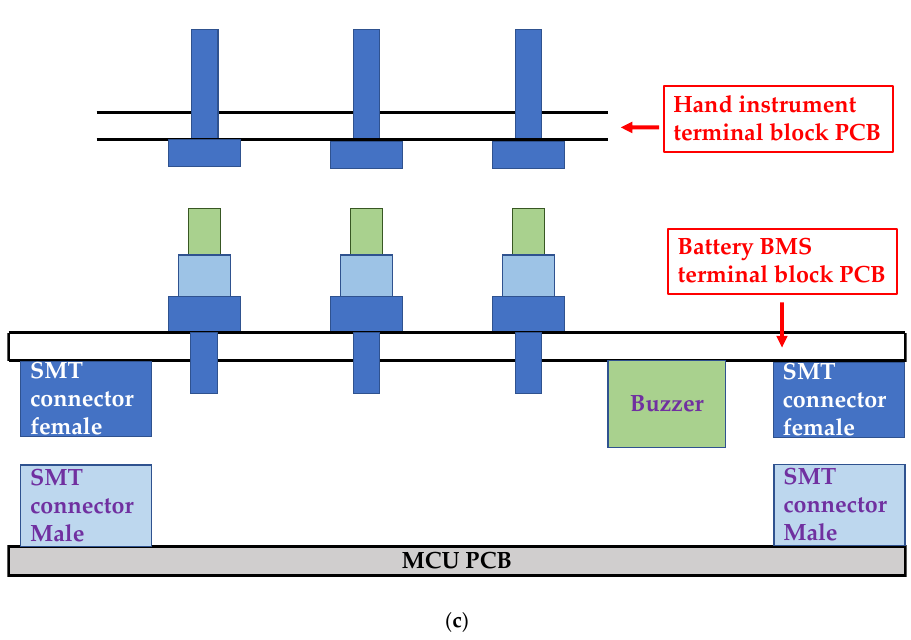
Figure 5. ( a ) BMS battery module configuration, ( b ) pulse code modulation (PCM)-DC/DC board configuration, and ( c ) terminal structure of the BMS and MCU.